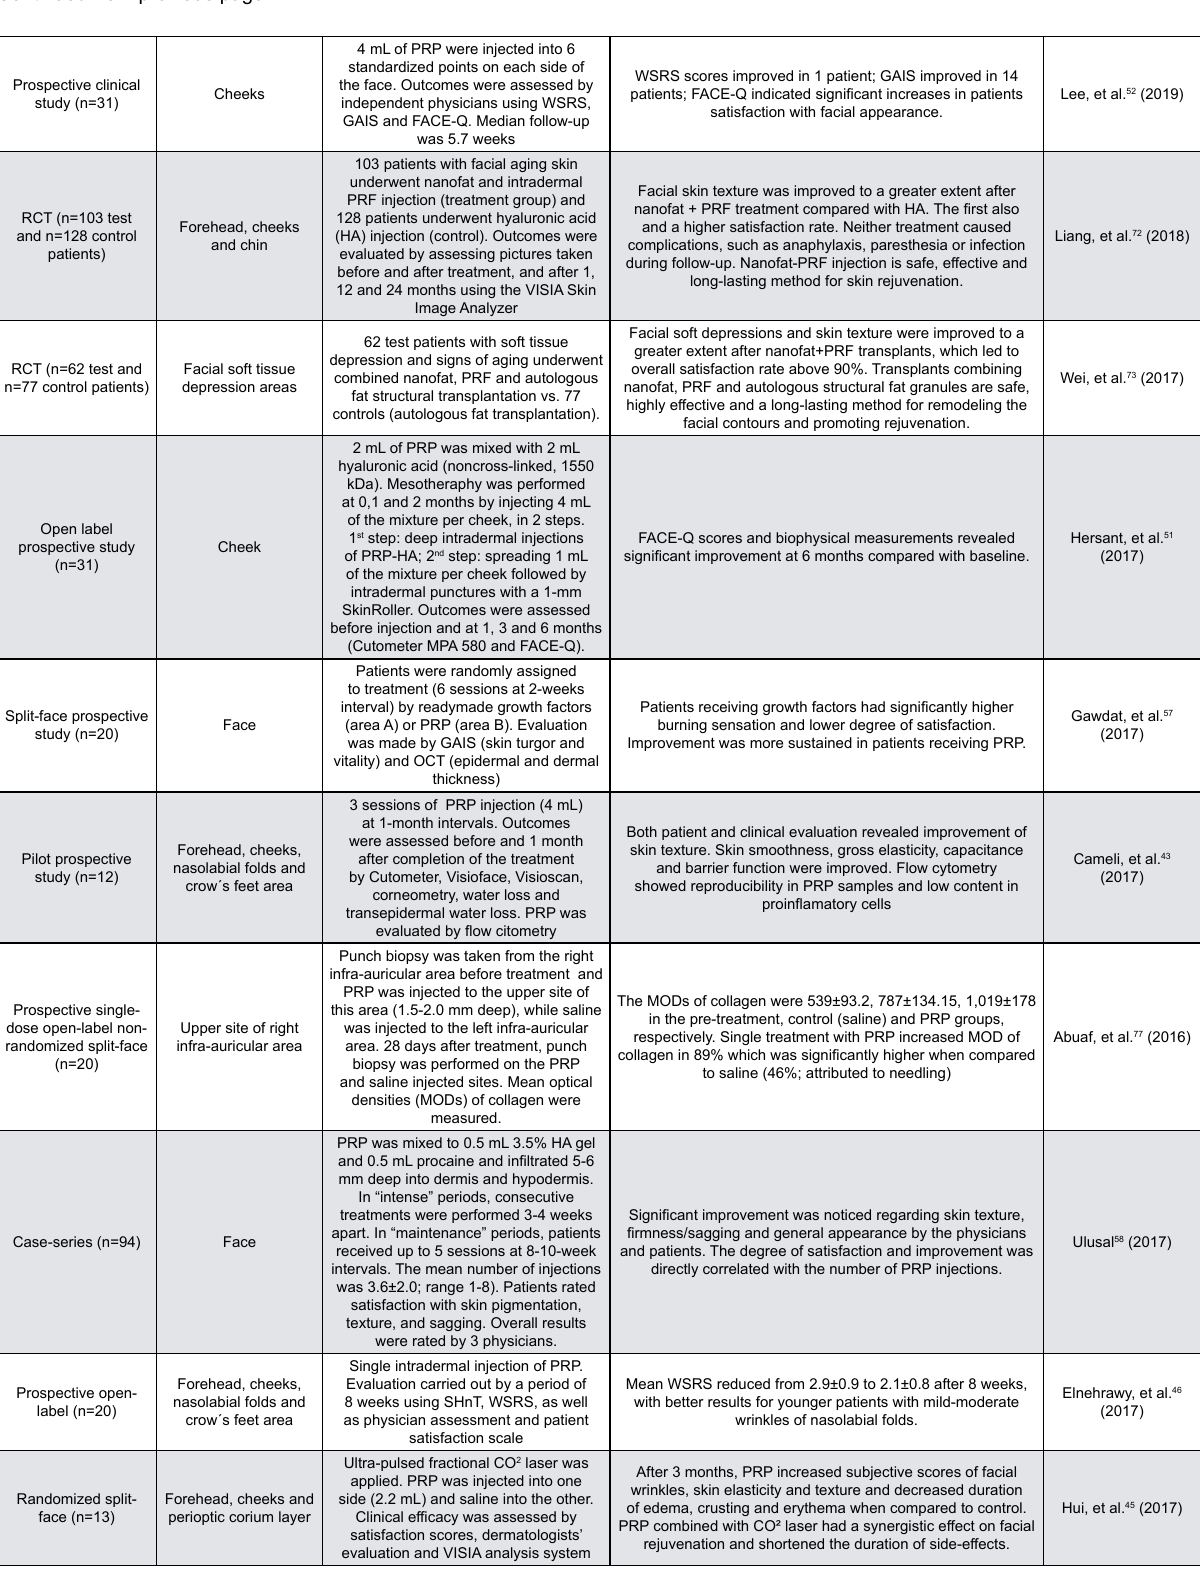
Figure 4- Clinical trials on the use of autologous platelet aggregates for facial